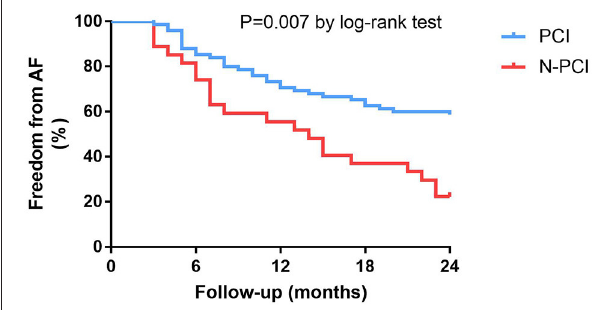
FIGURE 3 | Kaplan-Meier survival curves for freedom from atrial fibrillation recurrence in patients with obstructive CAD at 24-month